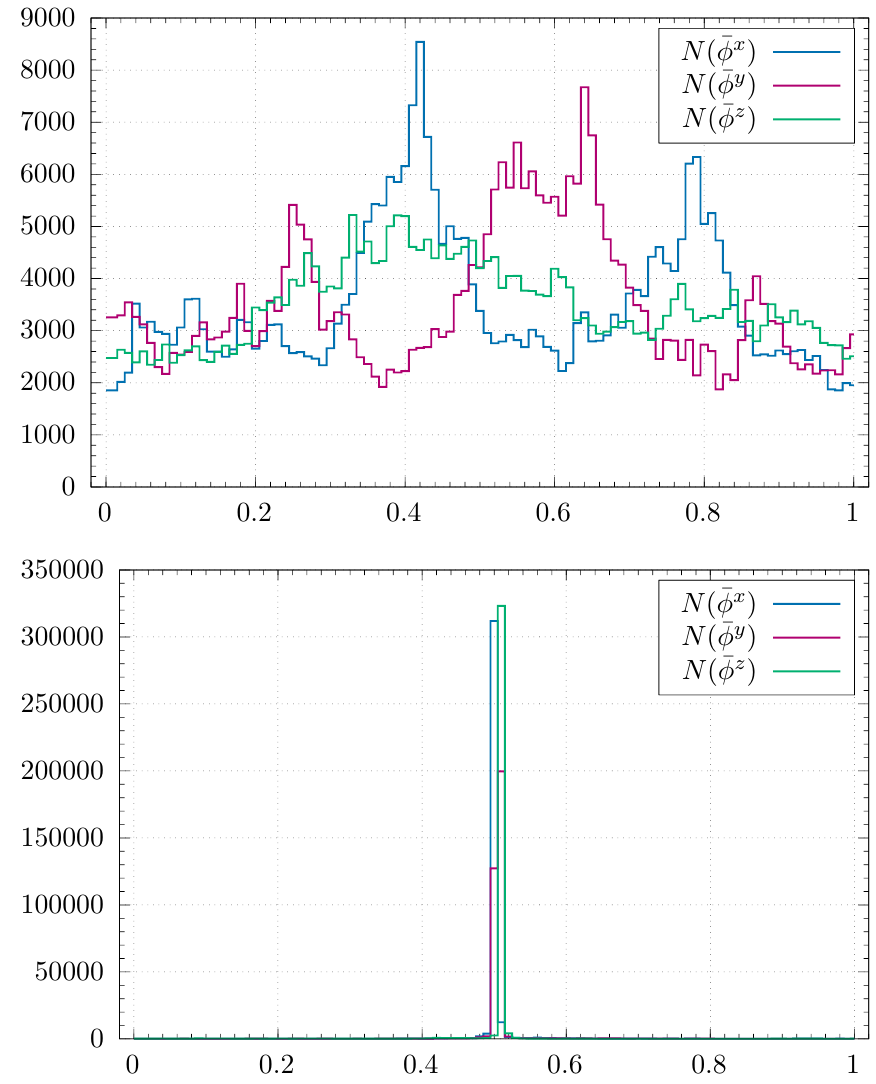
Figure 15. Top : the projection of four-volume, as defined by (20) in one spatial direction ( x , y or z ) for a typical CDT configuration with small jump magnitude δ = 0.1. Bottom : The projection of four-volume, as defined by (20), in one spatial direction ( x , y or z ) for a typical CDT configuration with large jump magnitude δ = 1.0. The horizontal axis is ¯ φ / δ